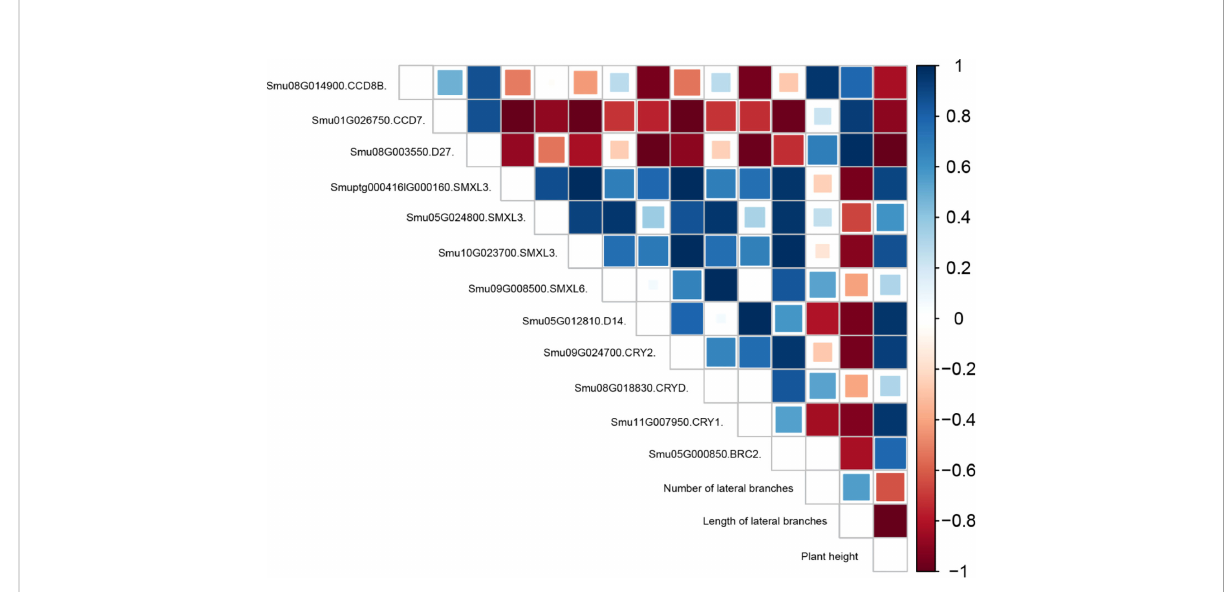
FIGURE 6 Correlation analysis between CCD , SMXL , D27 , D14 , CRY , and BRC2 genes and physiological traits under different light quality